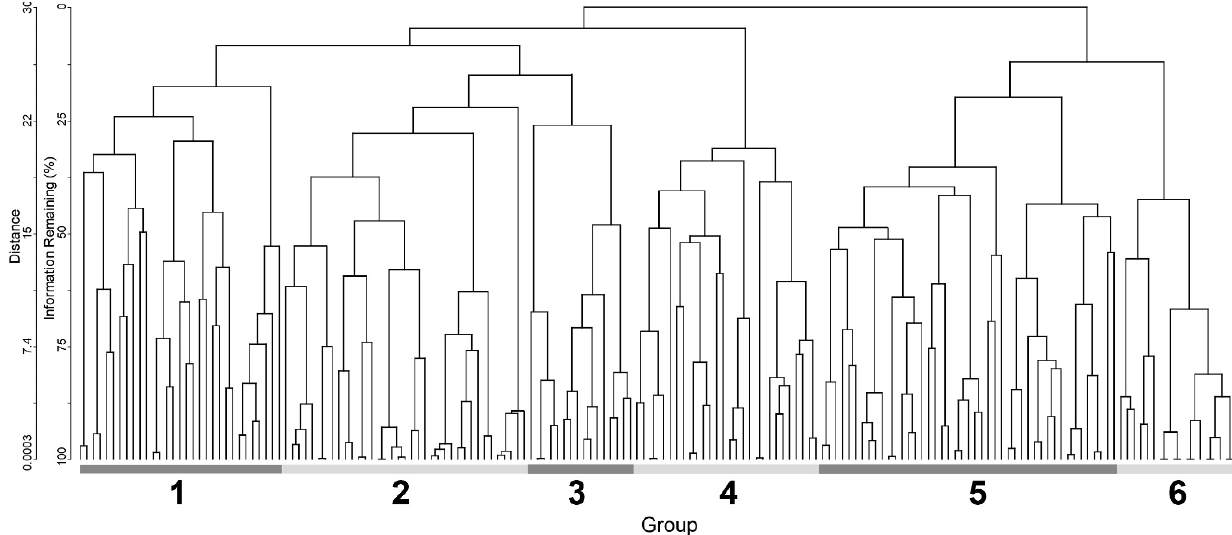
Figure 2. Dendrogram of analyzed relevés obtained with square root transformation of cover values in percentage, Beta flexible ( β = − 0.25) and group linkage with the relative Sørensen index. Legend: 1— Ranunculo–Alopecuretum typicum , 2— Trifolio – Alopecuretum rhinanthetosum , 3— Trifolio – Alopecuretum typicum , 4— Ventenato–Trifolietum , 5— Ranunculo–Alopecuretum filipenduletosum , 6— Ornithogalo – Trifolietum .